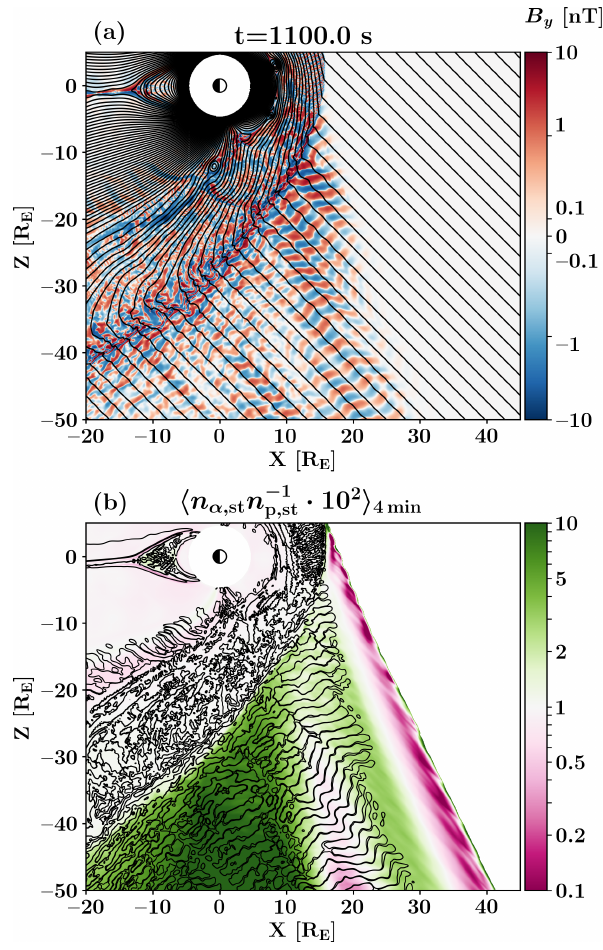
Figure 1. Overview of the foreshock region of the simulation. (a) Out-of-plane magnetic field fluctuations B y at 1100s, using a sym- metric logarithmic colour scale, indicating the extent of the ULF foreshock region. Black curves indicate magnetic field lines. (b) Ra- tio of suprathermal densities for helium over proton, normalized to the solar wind ratio of 1%, averaged over a period of 4min. The ra- tio is not shown in the pristine solar wind. Black contours are drawn for B y = ± 0 . 1nT at time t =